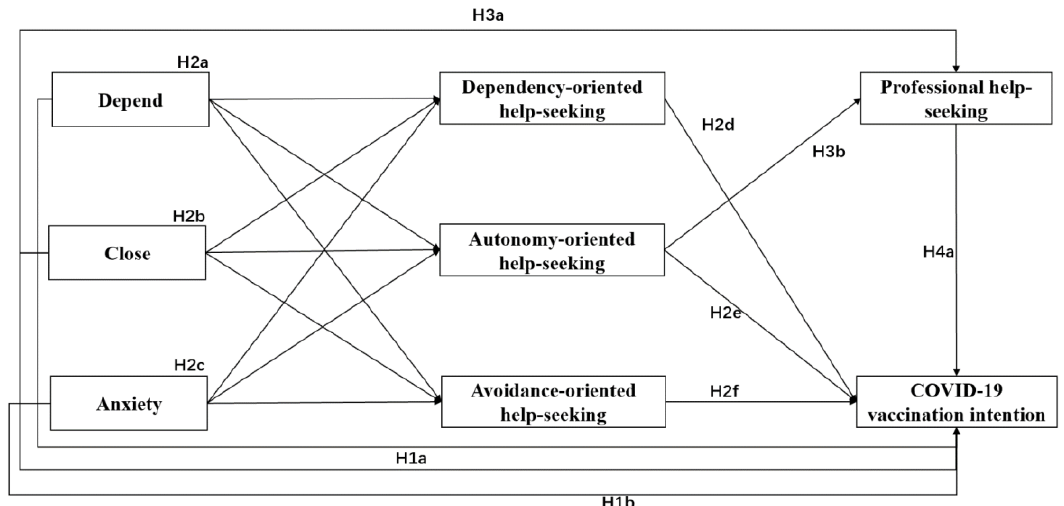
Figure 1. Hypothesized pathways from adult attachment to COVID-19 vaccination intention in the measurement model.